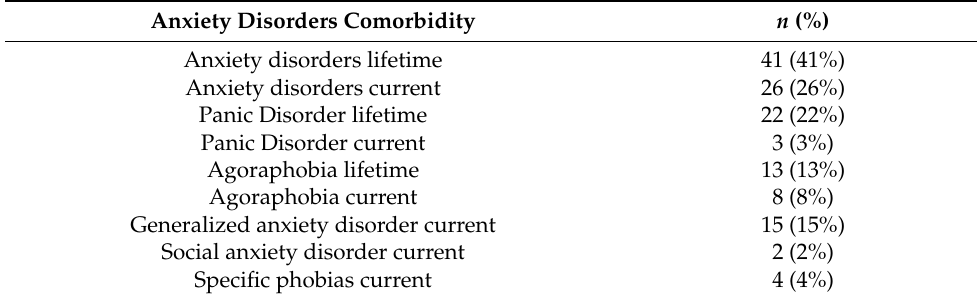
Table 1. Anxiety disorders in patients with Parkinson’s disease ( n =